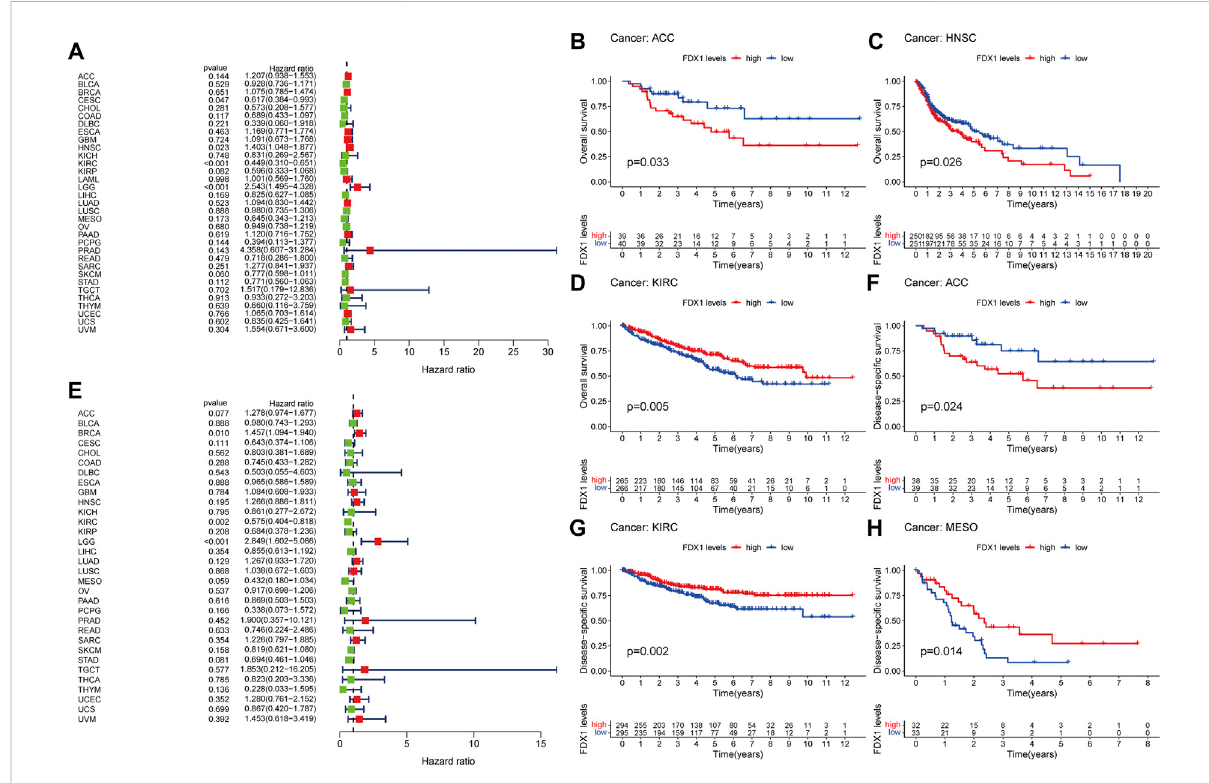
FIGURE 2 Prognostic assessment of FDX1 expression in OS and DFS. Correlation between FDX1 expression and OS (A) and DFS (E) by utilizing Cox proportional hazards model (B – D) Kaplan-Meier analysis of OS in patients with high and low FDX1 expression (F – H) Kaplan-Meier analysis of DFS in patientswithhighandlowFDX1expression.HR(hazardratio) > 1indicatesthatFDX1maybeanadversefactorintheoccurrenceanddevelopmentof cancer, and it is shown in red; 0 < HR < 1 indicates that FDX1 may be a protective factor in cancer, and it is shown in